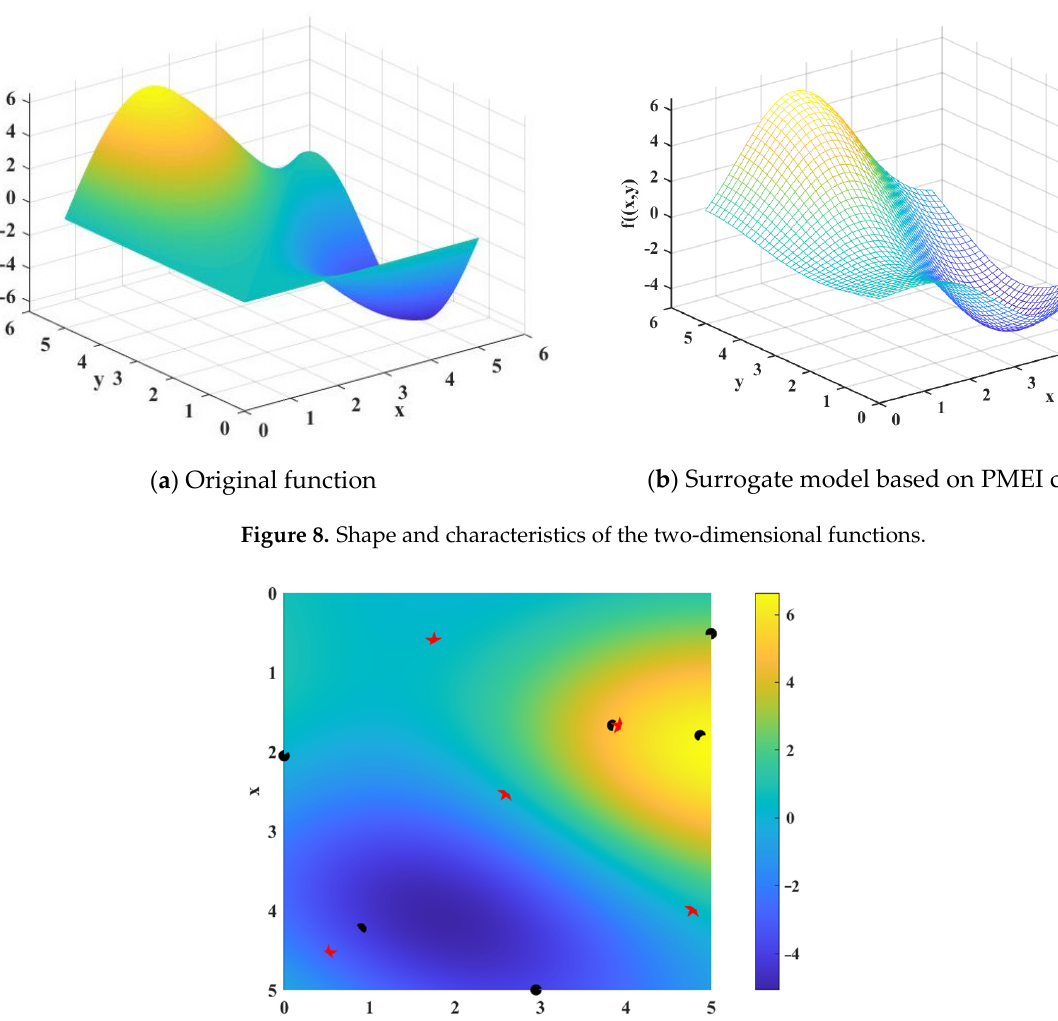
Figure 9. Sampling points for the two-dimensional function.